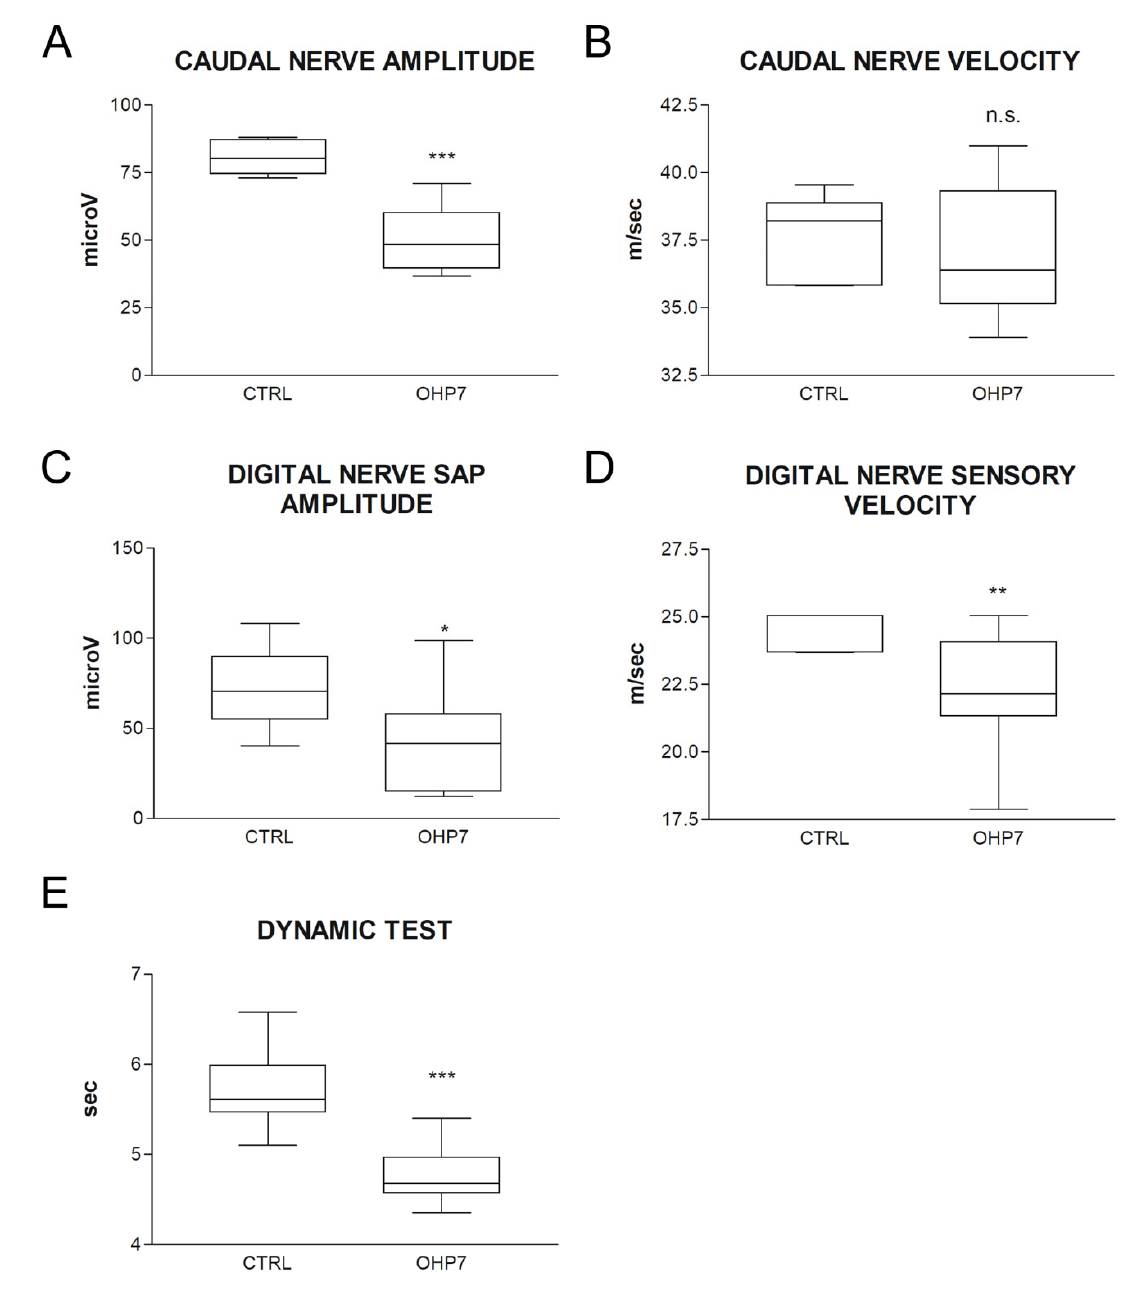
Figure 3. In ( A–D ): nerve conduction study data at the end of treatment is shown. In ( E ) Dynamic (mechanical allodynia) test data at the end of treatment is shown. Statistical significance of Mann– Whitney U-test is shown in all graphs. The box-and-whiskers graphs show median and quartile values, as well as maximum and minimum values. * p -value < 0.05 vs. CTRL, ** p -value < 0.01 vs. CTRL, *** p -value < 0.001 vs. CTRL. CTRL: control group; OHP7: OHP-treated group. SAP: sensory action potential. n.s. means no significance.